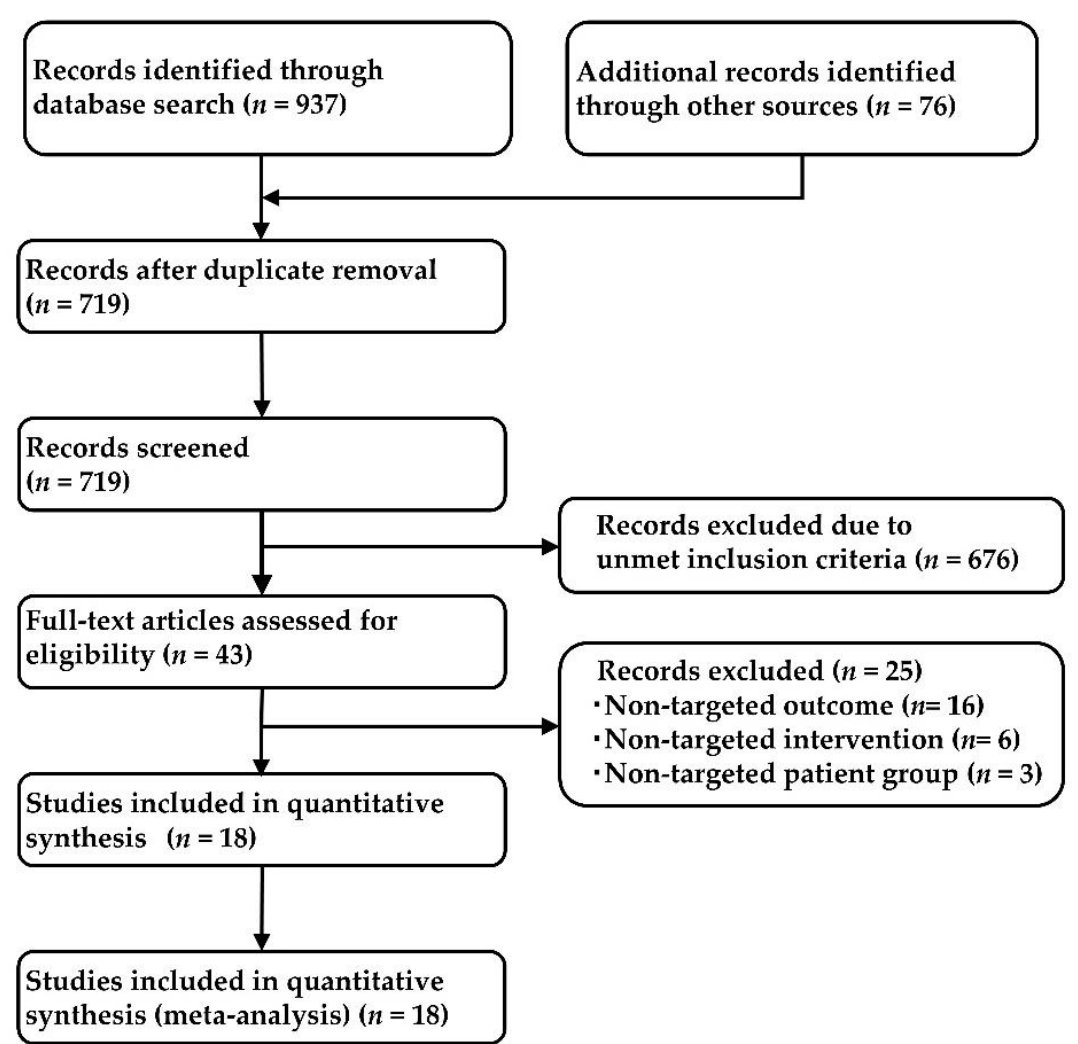
Figure 1. Flow diagram of the study selection process.